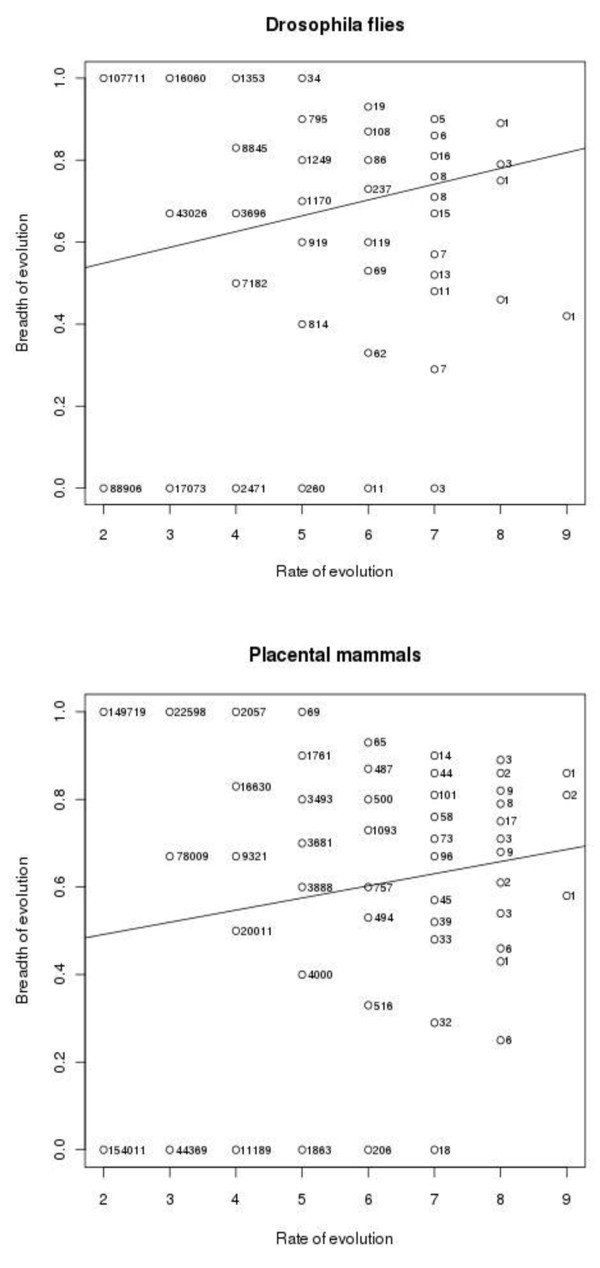
Numbers of sites with different combinations of values of n and B in Drosophila flies (left) and placental mammals (right) calculated using classes of amino acids.